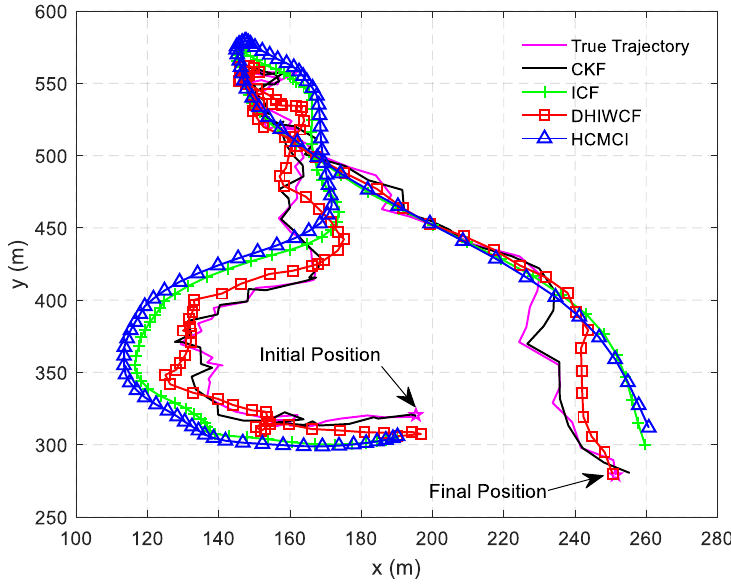
Figure 14. The true and estimated tracks of di ff erent